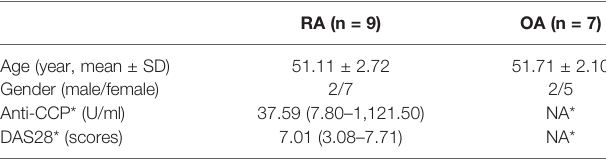
TABLE 1 | Clinical characters and laboratory measures of the